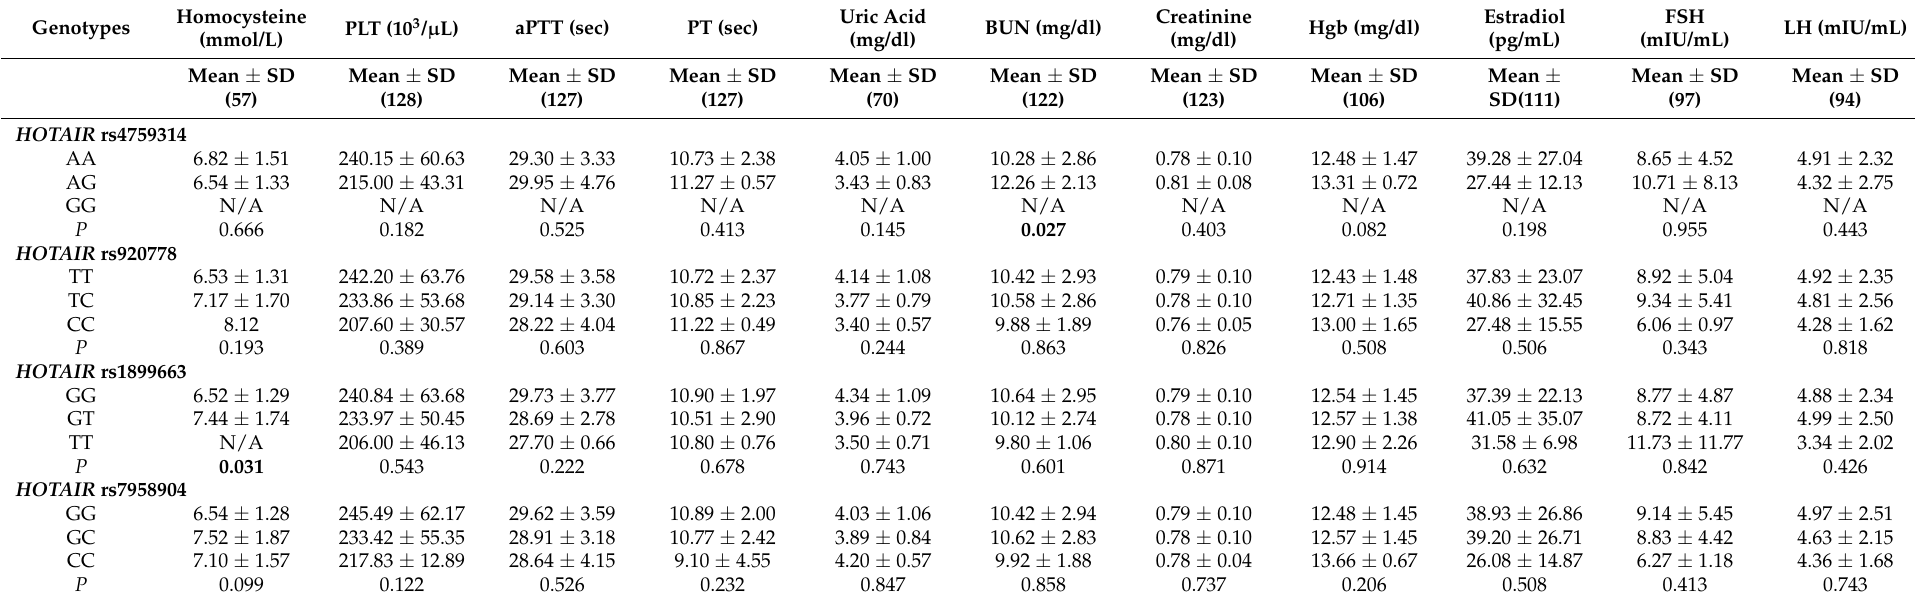
Table 6. Differences in clinical parameters according to HOTAIR gene polymorphisms among RIF